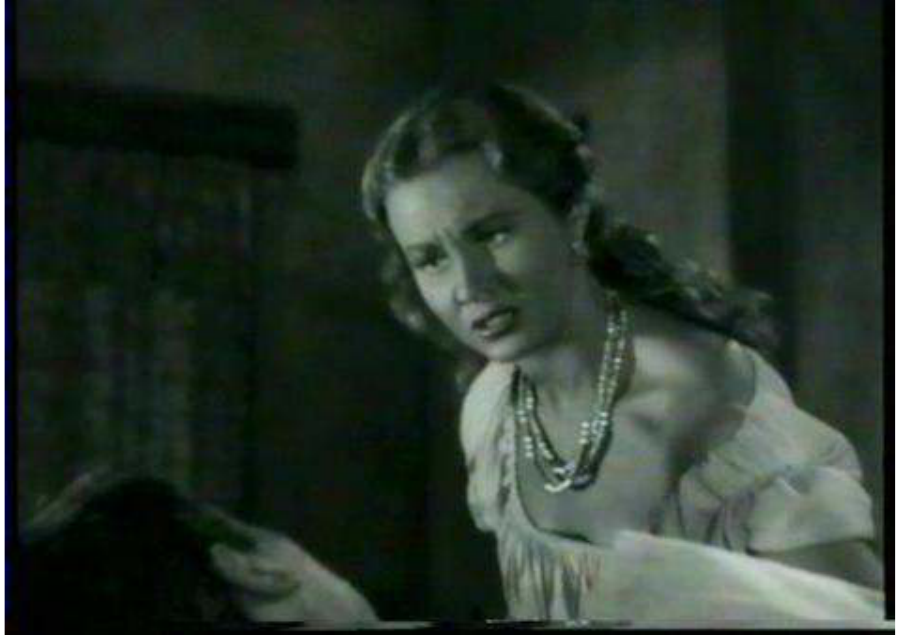
Figure 16: The woman in charge in Colorado Territory